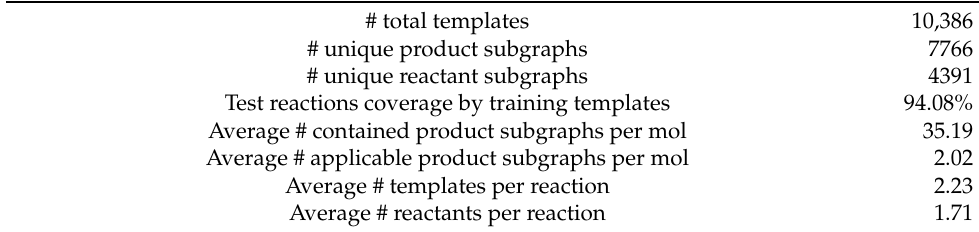
Table A2. Statistical results of templates and reactions. # is the short for